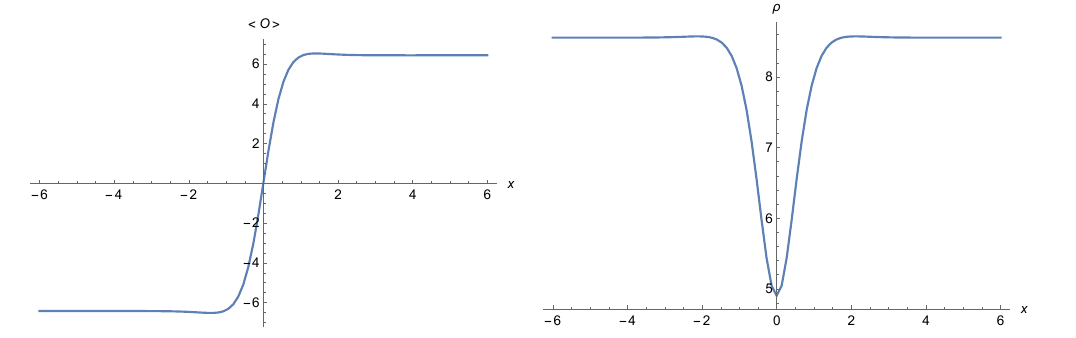
Figure 2 . The order parameter (left panel) and particle number density (right panel) with respect to x for (cid:22) = 5 :